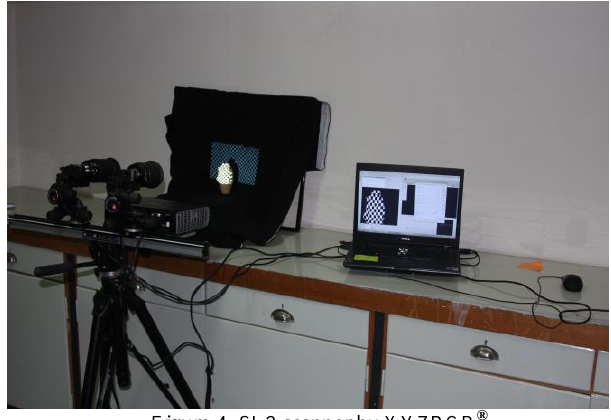
Figure 4: SL2 scanner by XYZRGB ®